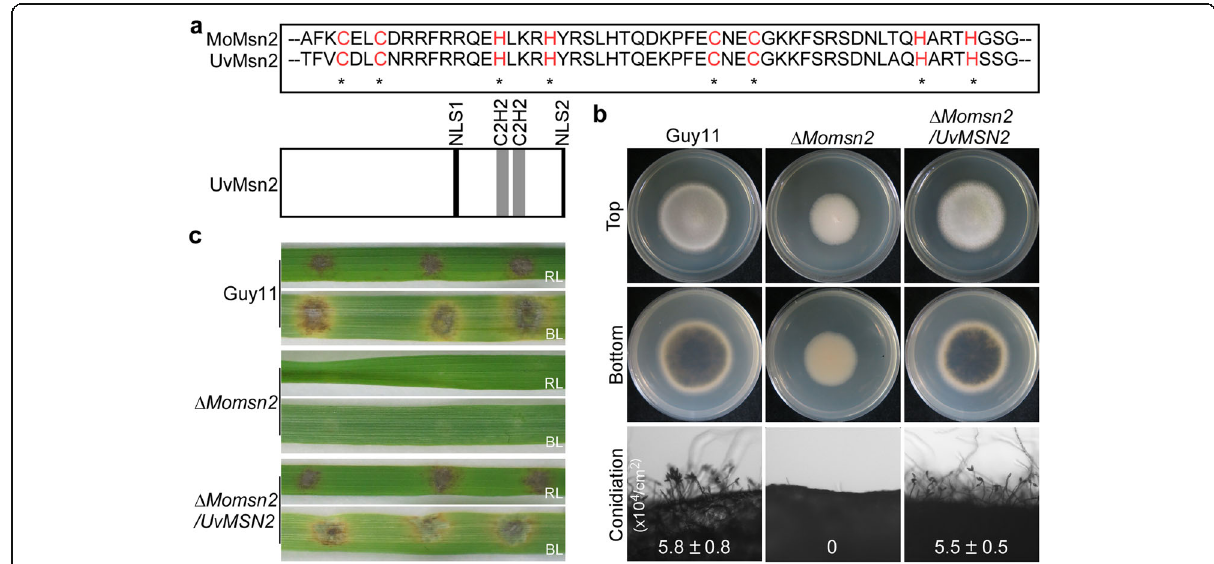
Fig. 1 UvMsn2 is a homolog of MoMsn2 from Magnaporthe oryzae. a Sequence alignment and domain prediction of UvMsn2. b Vegetative growth and conidiation of the M. oryzae wild-type Guy11, Δ Momsn2 mutant and heterologous complemented transformant Δ Momsn2/UvMSN2 . The mean values ±SD were calculated from three independent experiments. c Pathogenicity assays on detached rice and barley leaves. The diseased leaves were photographed at 5 and 7 days post-inoculation (dpi) for barley and rice, respectively. RL: rice leaf; BL: barley